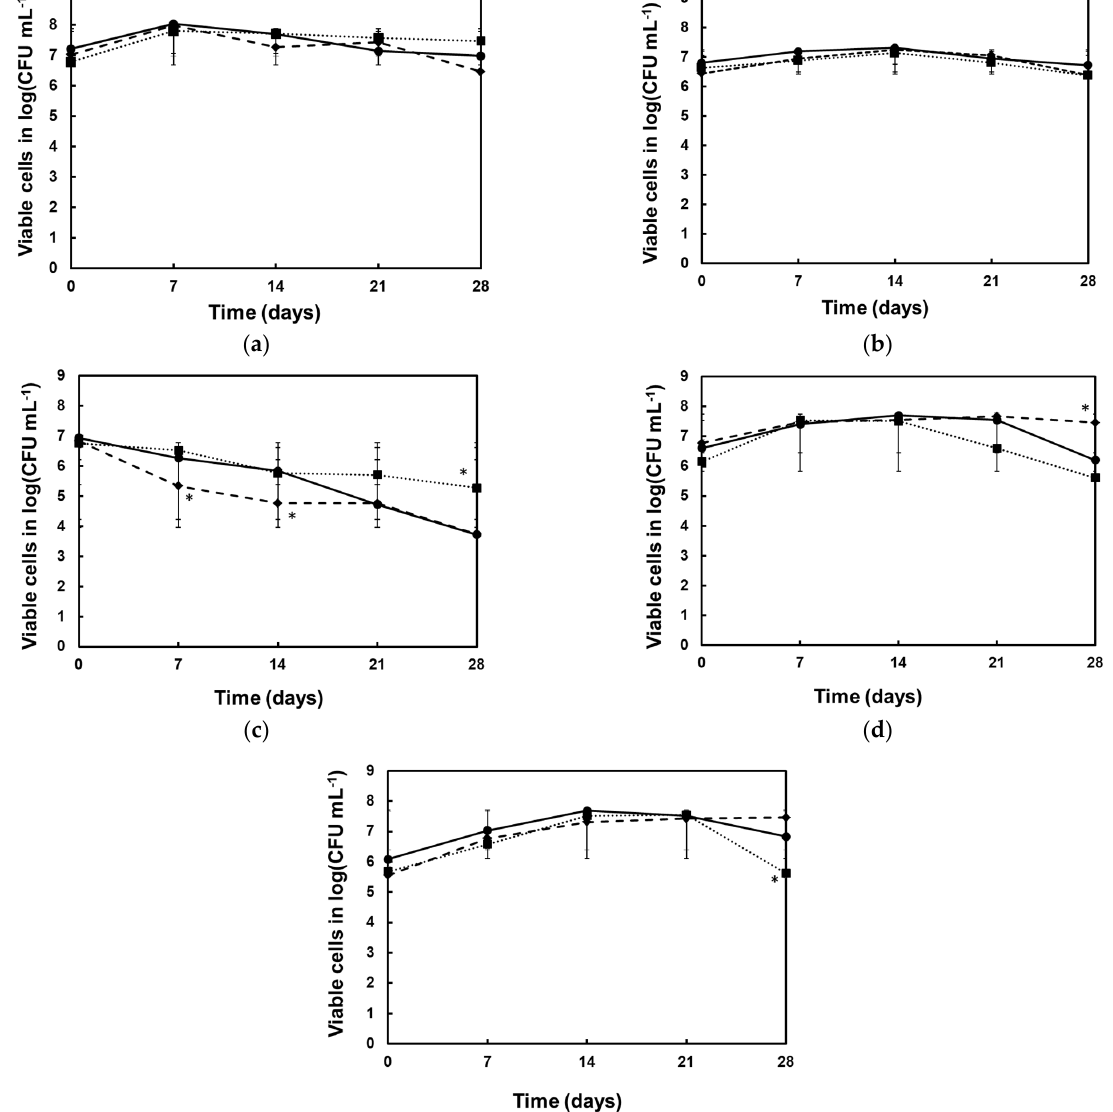
Figure 6. Inhibition of microorganisms growth in cosmetic emulsions with refined olive oil (continued line), ozonated olive oil 0.04 mole O 3 /100 g oil (discontinued line), ozonated olive oil 0.10 mole O 3 /100 g oil (dotted line): ( a ) E. coli ; ( b ) P. aeruginosa ; ( c ) S. aureus ; ( d ) C. albicans ; ( e ) A. brasiliensis ; * marks statistically significant differences ( p < 0.05).